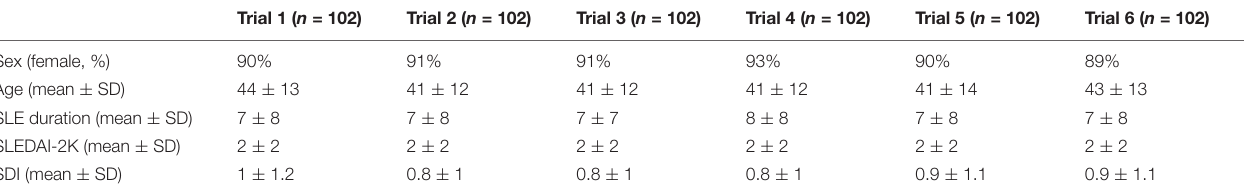
TABLE 1B | Patient population characteristics for the six training sets.